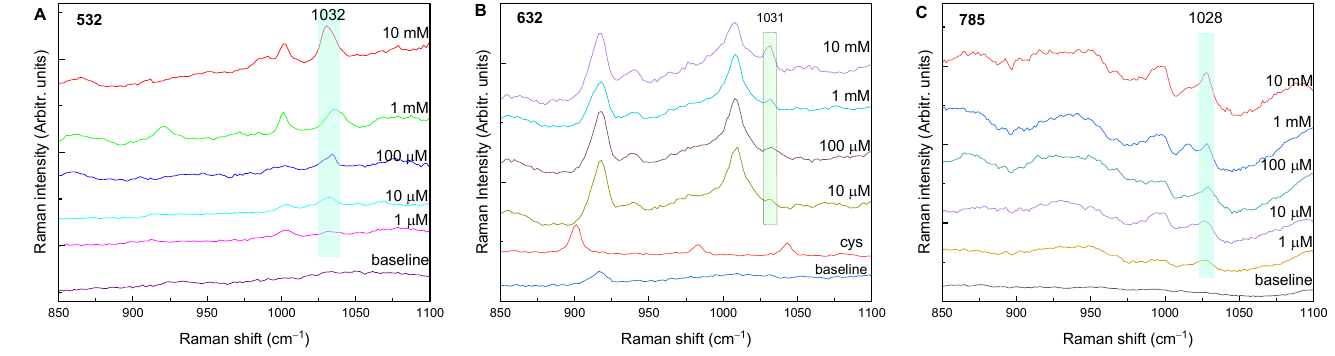
Figure 5. SERS spectra of different glyphosate concentrations with cysteamine-modified NPs: ( A ) Ag with 532 nm excitation, ( B ) Au with 632 excitation and ( C ) Au with 785 nm excitation. (cys: cysteamine powder). Using NPs modified with cysteamine, good glyphosate bands at ≈ 1030 cm − 1 were obtained with Ag NPs and excitation at 532 nm and with Au NPs and excitations at 632 and 785 nm. This peak is present in all spectra, and its intensity decreases